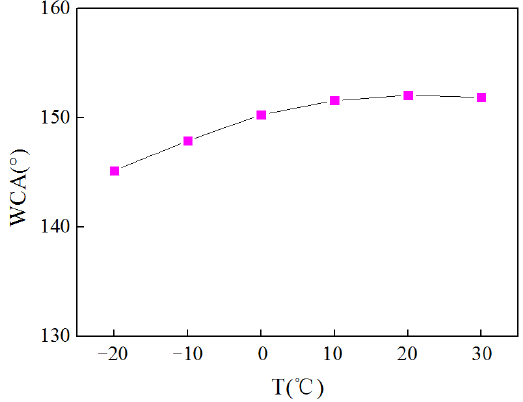
Figure 8. Different ambient temperature MoS 2 /ZnO/PDMS coating surface hydrophobic Figure 8. Di ff erent ambient temperature MoS 2 /ZnO/PDMS coating surface hydrophobic angles .